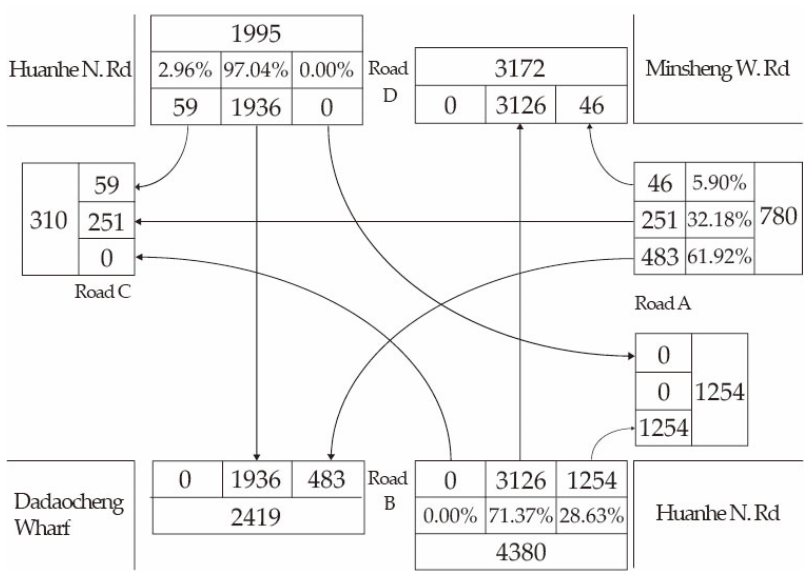
Figure 4. Road traffic data from 8:00 a.m. to 9:00 a.m. on Huanhe N. Rd. and Minsheng W. Rd.